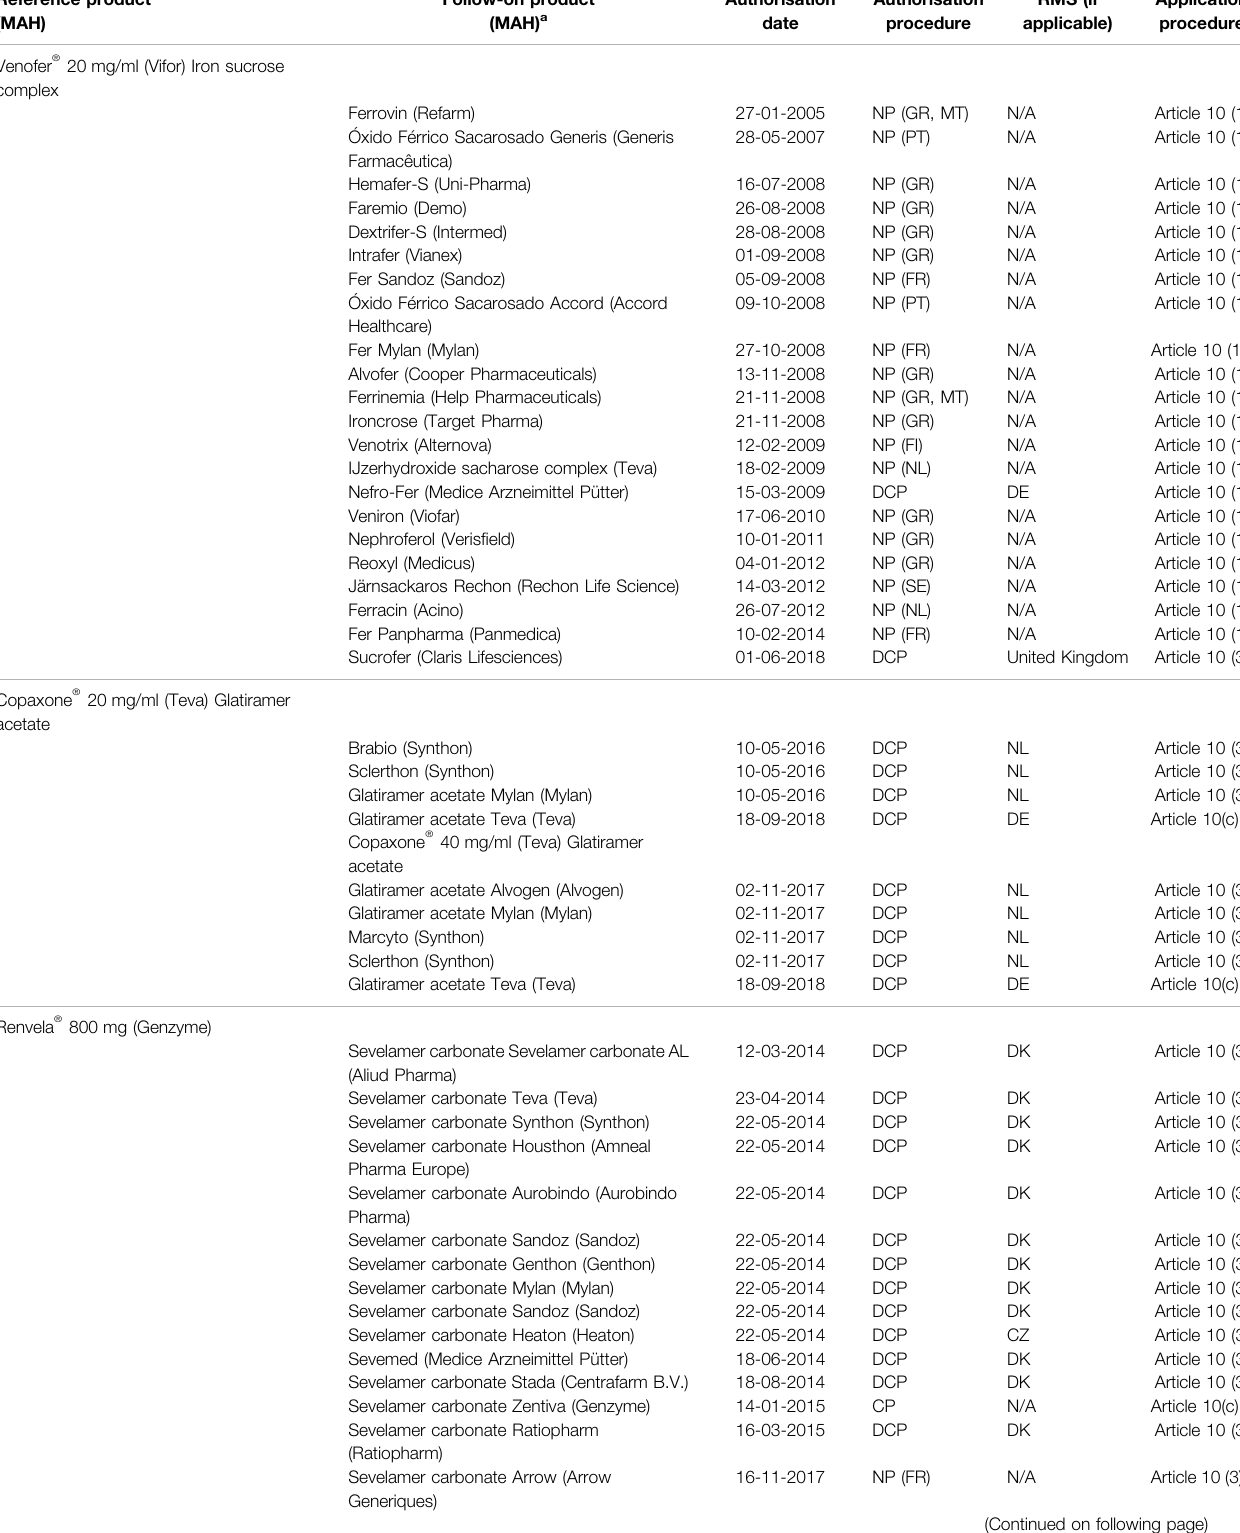
TABLE 2 | Overview of NBCD follow-on products approved in the EU via the three abbreviated applications: generic, hybrid, and biosimilar pathways, as well as new applications by originator companies via informed consent, sorted by authorization date since the fi rst approval in 1999 until November 2018. Reference product